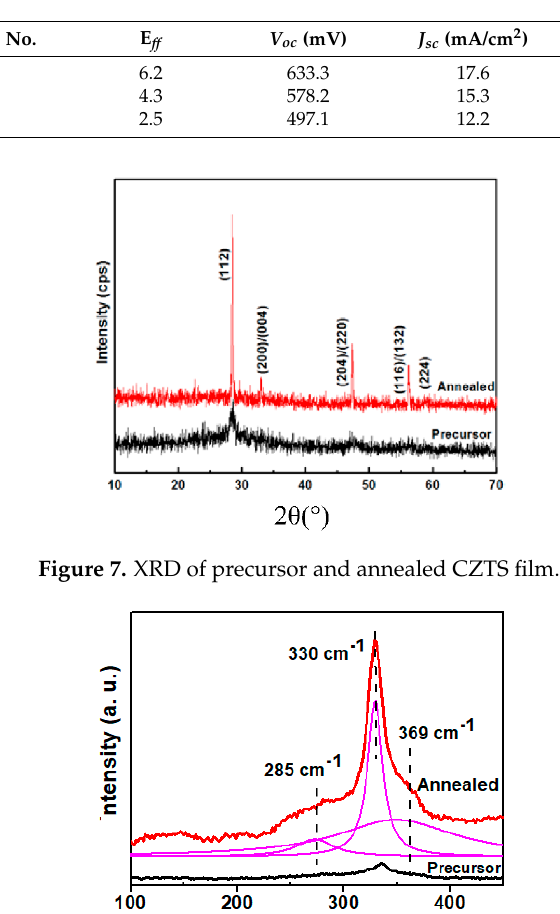
Table 2. Performance of CZTS solar cells. Figure 8. Raman spectrums of precursor and annealed CZTS film with fitting of the peaks using Lorentzian curve.